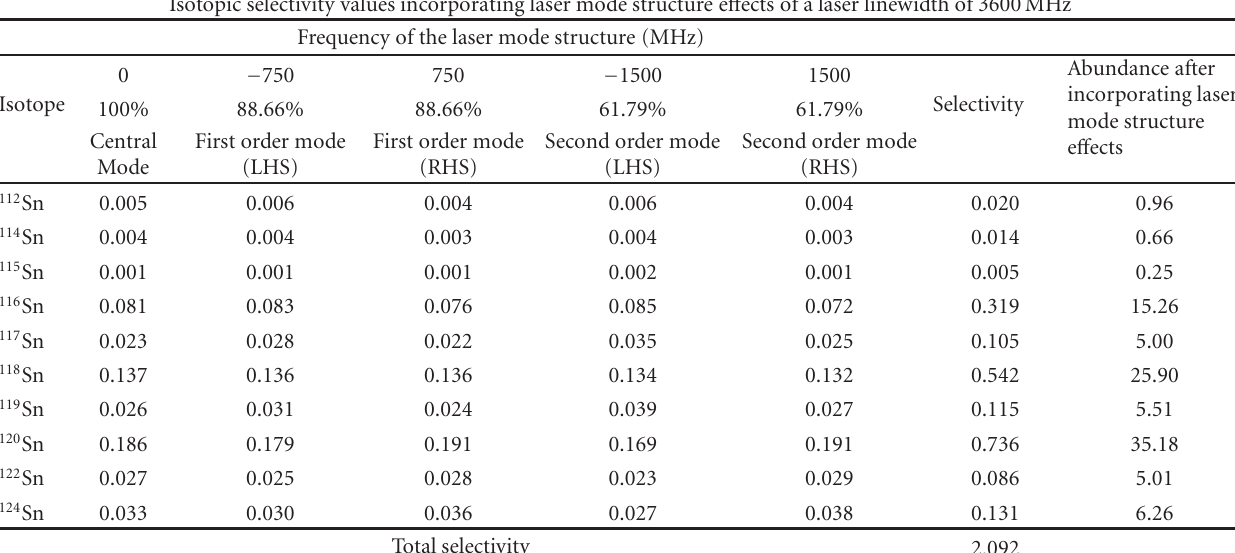
Table 5: A table of theoretically computed isotopic selectivity and abundance values after incorporating laser mode structure e ff ects of a laser with a linewidth of 3600MHz.